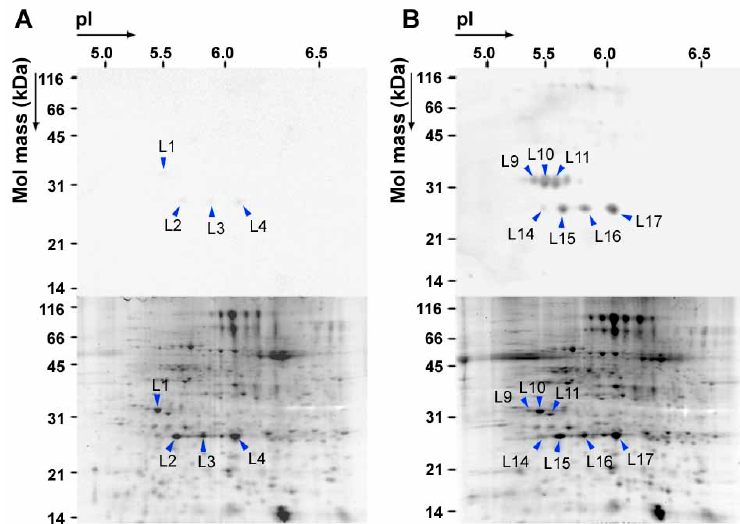
Figure 3. 2D PAGE gel patterns of Arabidopsis whole leaf proteins extracted from + NO 2 -treated (right) and –NO 2 control (left) plants. Western blots detected using 3-NT-specific antibody (upper panels) and gels stained with SYPRO Ruby (lower panels). Each gel was loaded with 100 µg protein. The number of 3-NT-positive spots was markedly increased in purified and fractionated chloroplast proteins (Figure 4, Table S3) [57]. Distinct 3-NT-positive protein spots were lined at 32